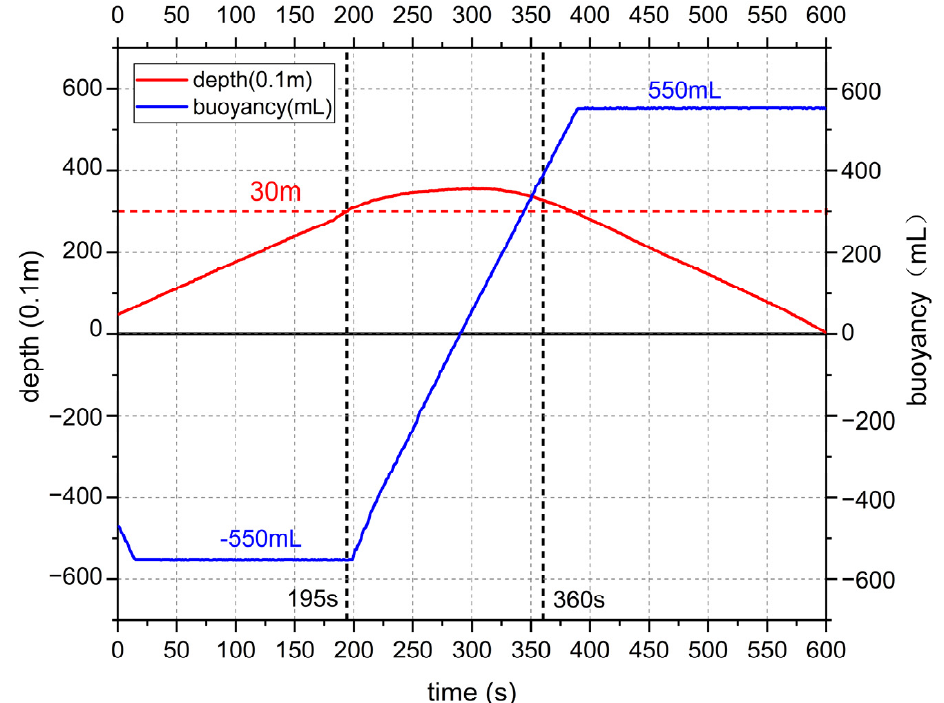
Figure 7. The depth and buoyancy changed with time. The red dot line denotes the target depth of 30 m. The picture shows the prototype glide to the target depth of 30 m and then float up to the surface. The buoyancy was set to − 550 mL and 550 mL when gliding down and up, respectively.